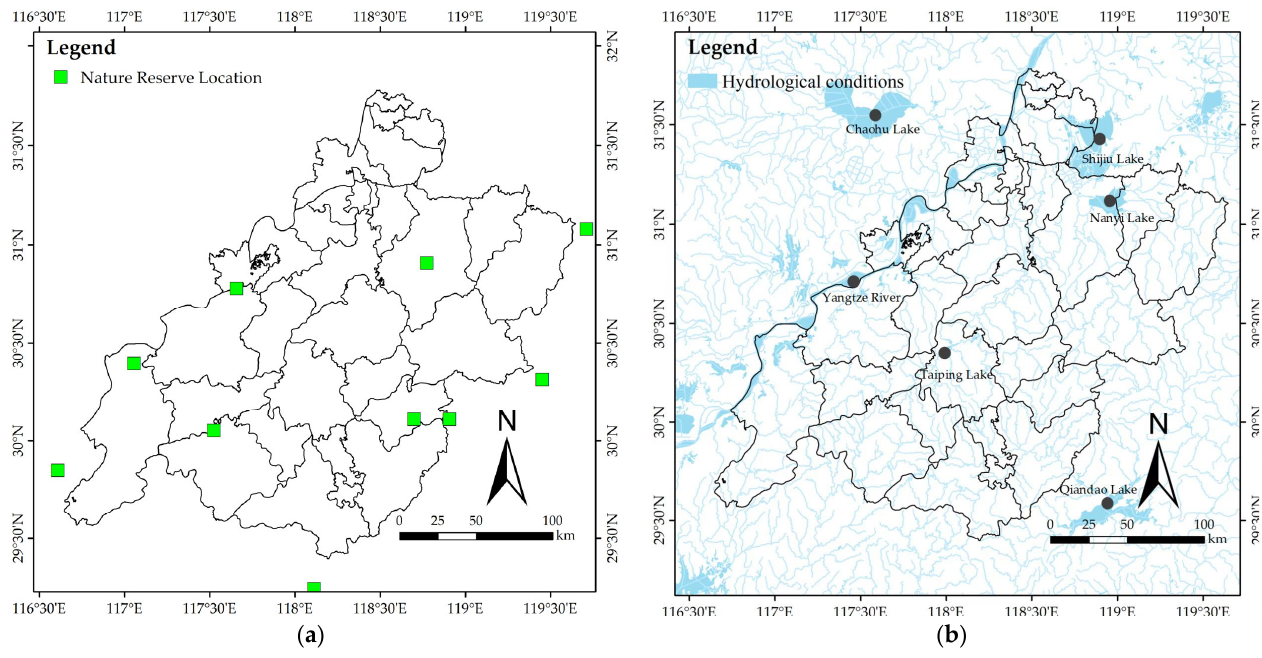
Figure A3. Spatial distribution of hydrological conditions and protected areas in southern Anhui; ( a ) Nature reserve locations in southern Anhui. ( b ) Hydrological conditions in southern Anhui.